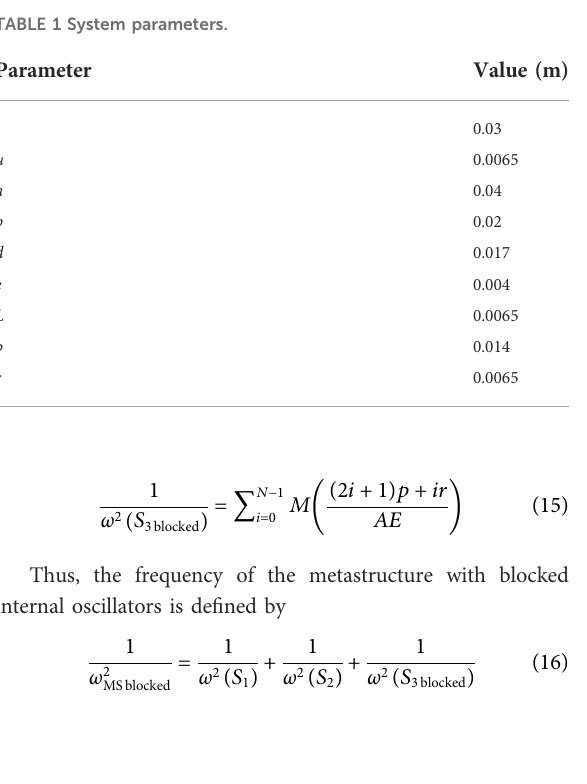
TABLE 1 System parameters.